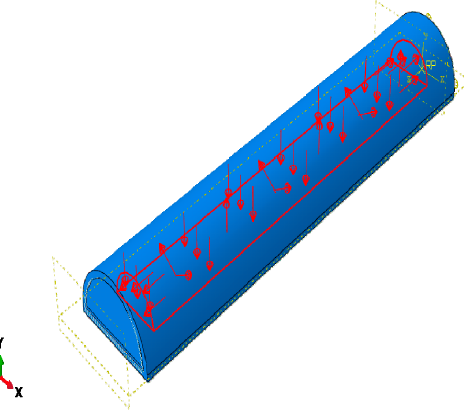
Figure 7. Load applied to the inner surface of the SPA .